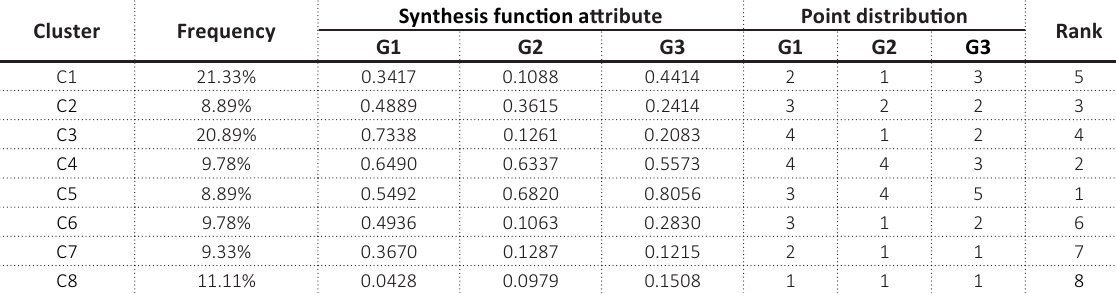
Table 9. Cluster rating